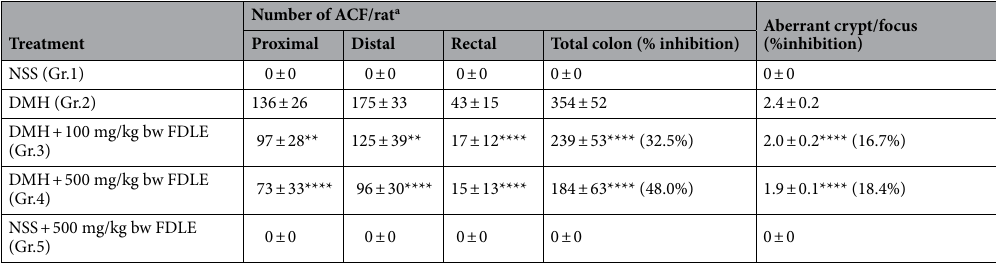
Table 3. The number of ACF and AC/F in DMH-treated rats with and without FDLE administration in post- initiation stage. a Mean ± SD of 10 rats per group, **p < 0.01, ***p < 0.001, ****p < 0.0001, Significantly different from